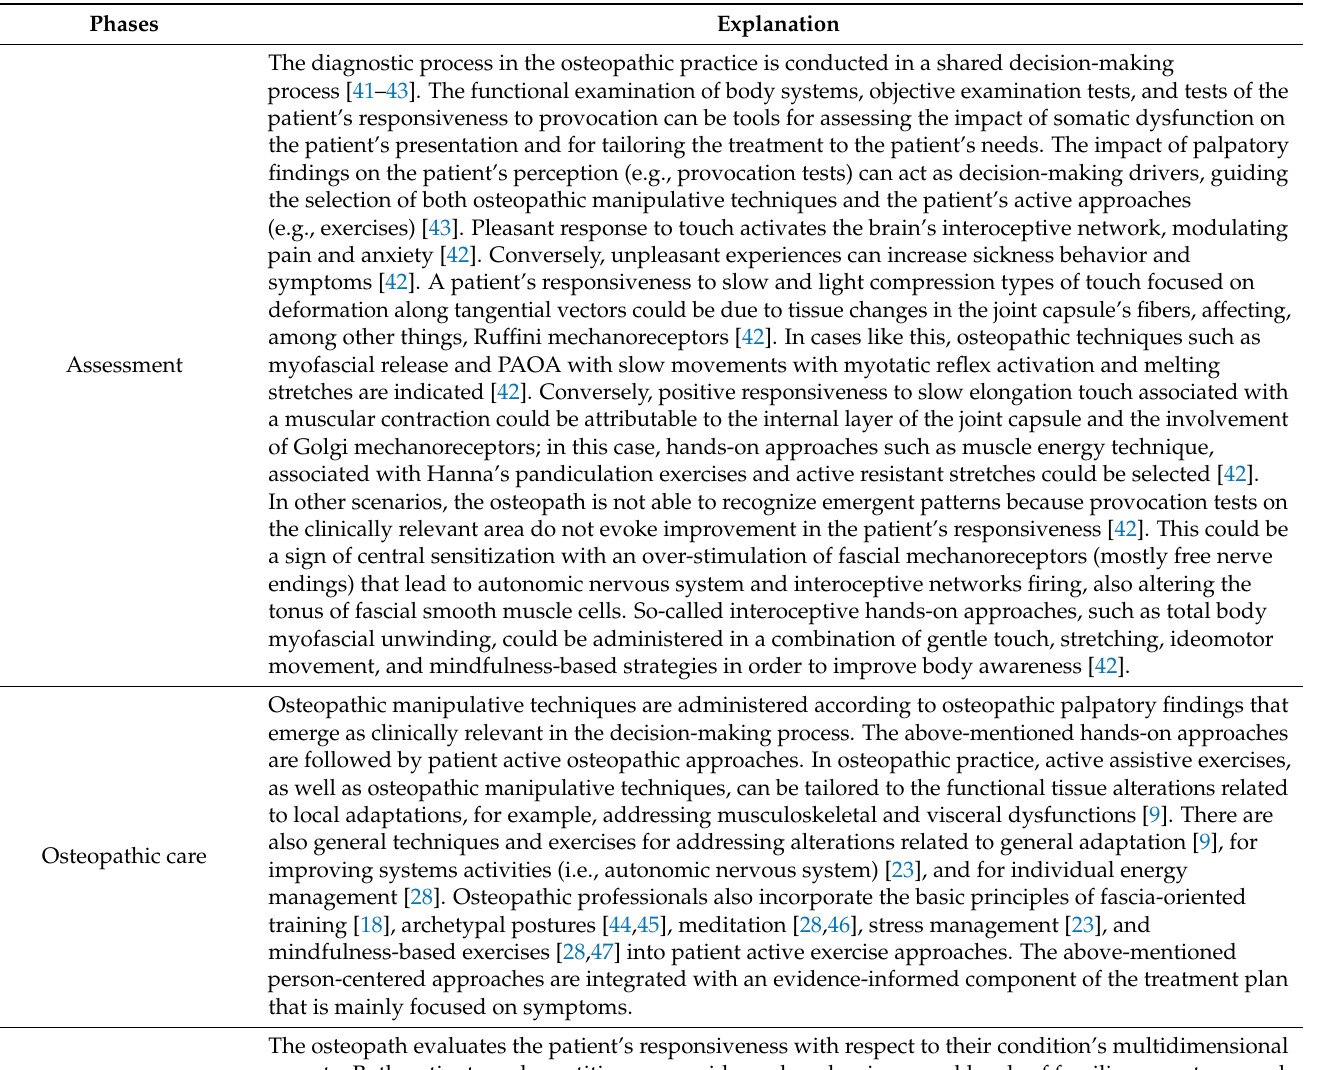
Table A1. Patient active osteopathic approaches. Selection and integration in the hands-on treat- ment